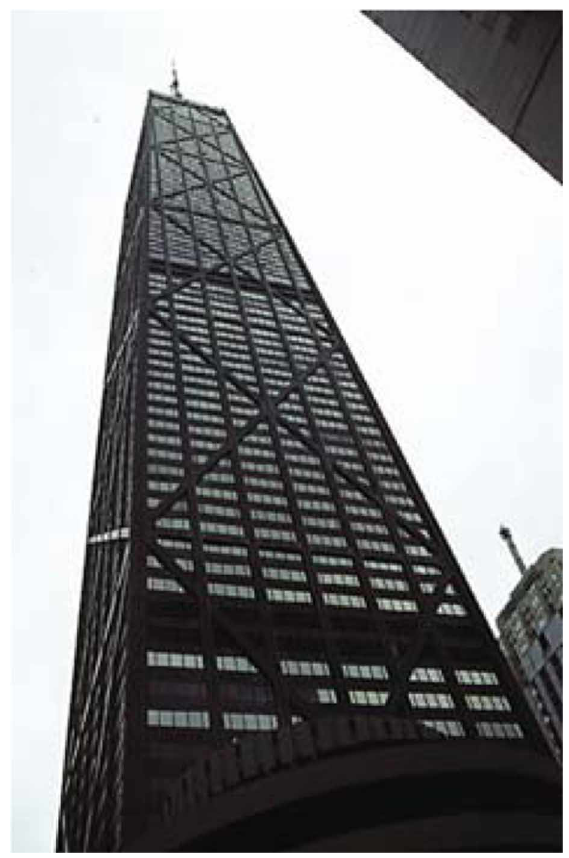
Fig. 1. The use of LSB system in John Hancock, Chicago (Leonard 2007)